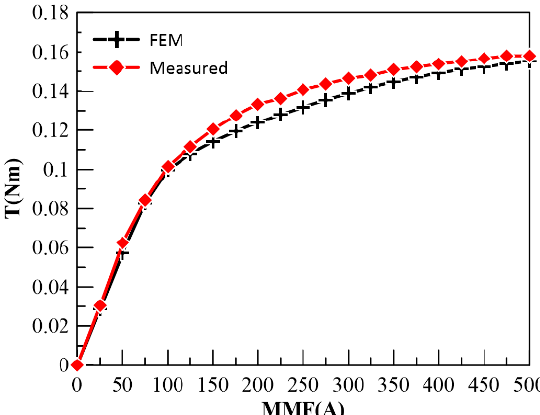
20 of 28 Figure 23. Angular displacement curve. The electromagnetic torque is a crucial index of the torque motor. Figure 24 gives the electromagnetic torque angle characteristic curve of CPMLTM. When measuring the elec- tromagnetic torque moment angle characteristic, the magnetic potential generated after the coil is energized is 100 A. It can be found that the difference between the experimental data and the simulation gradually increases with the increase of the turning angle, which is because the coaxiality between the torque sensor, the tension sensor, and the prototype cannot be guaranteed, so the error will be generated during the rotation. Figure 24. The electromagnetic torque angle characteristic curve of CPMLTM. When the rotor is in the neutral position, the relationship between the coil MMF and